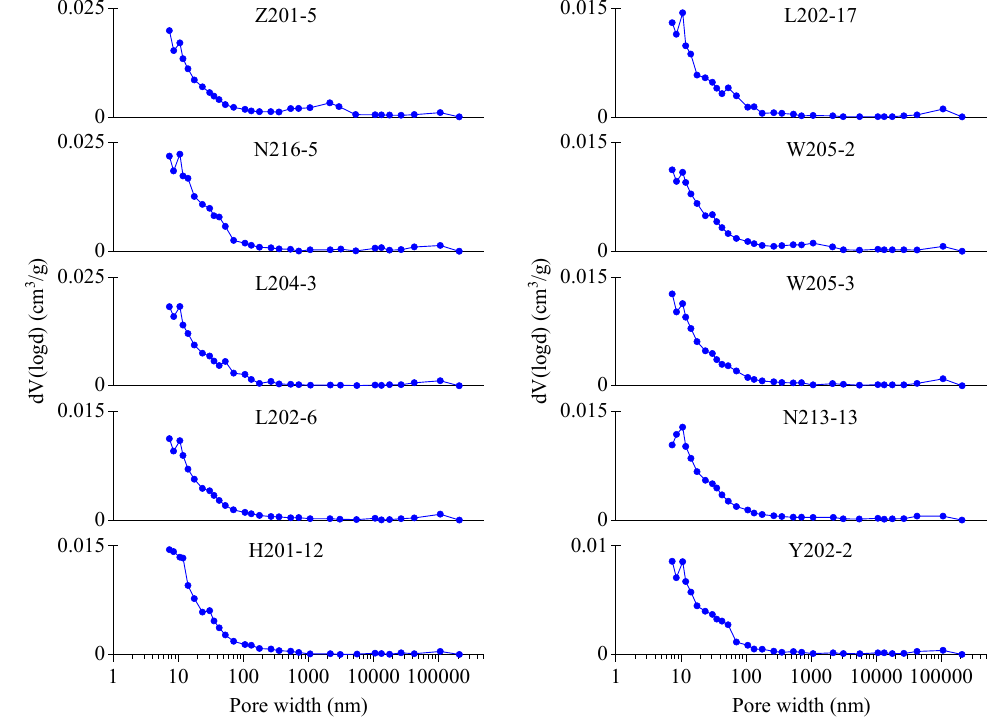
Figure 11. Pore size distribution curves from HMIP analysis.